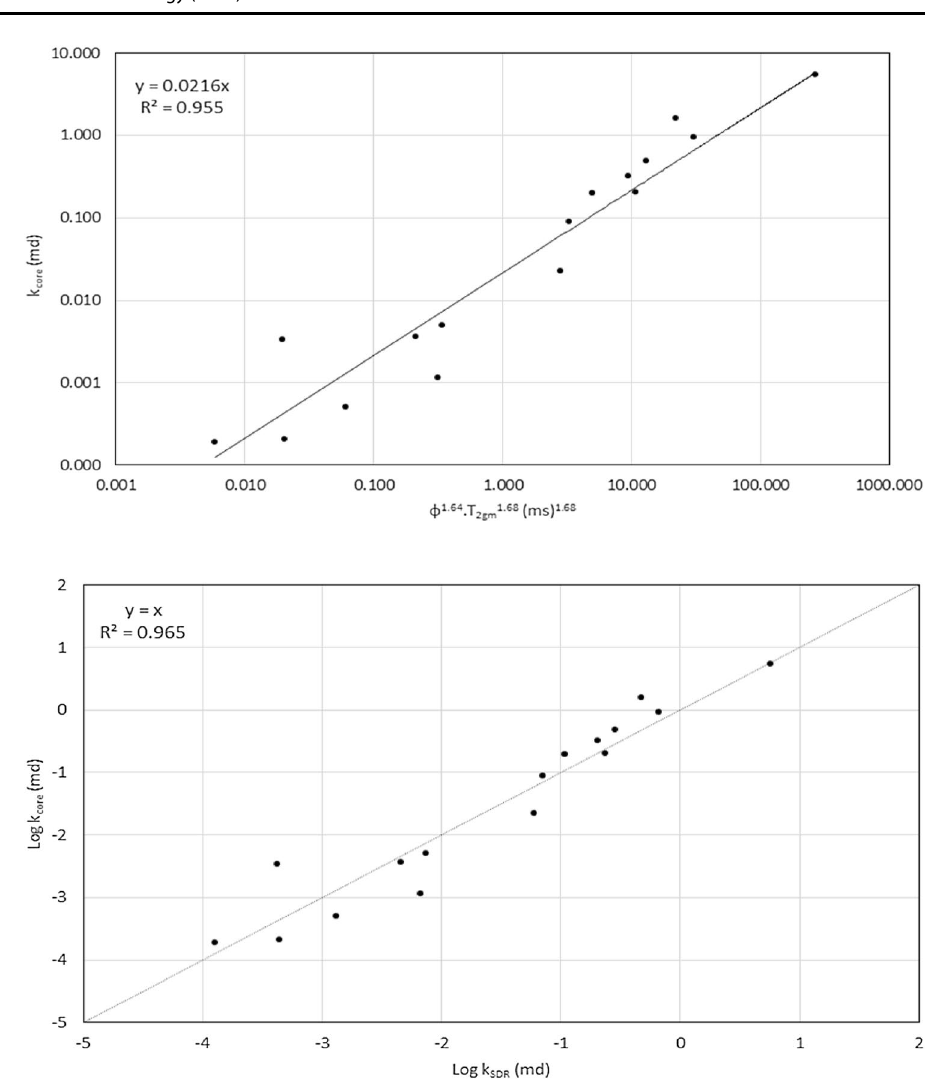
Fig. 13 A determination in modified SDR model (design model, m = 1.64, n = 1.68)